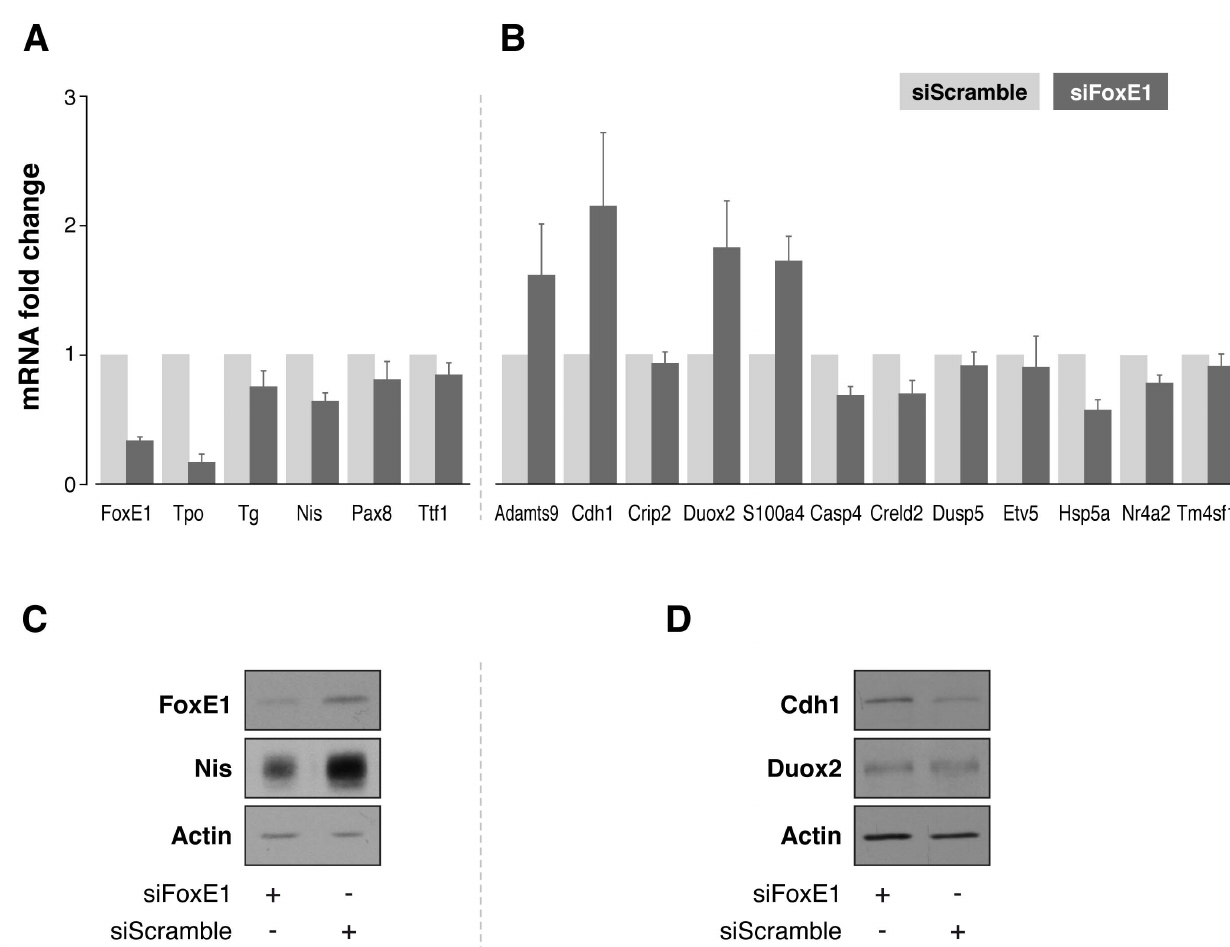
Figure 2. Experimental validation of microarray results by qRT-PCR and western blotting. Relative expression assessed by means of qRT- PCR of 6 thyroid-specific genes (panel A) and 12 additional genes differentially down- and upregulated in FoxE1-silenced PCCl3 cells (panel B). As FoxE1-dependent positive controls, we evaluated Tpo and Tg mRNA expression levels. Relative gene expression in siFoxE1 samples was calculated using the corresponding siScrambl samples as a reference (=1). Results are mean 6 SEM of four independent experiments. Total protein extracts were prepared and submitted to western blot analysis to assess the protein levels of FoxE1 and Nis (panel C), and of Cdh1 and Duox2 (panel D). Actin was used as loading control. Representative western blot assays of four independent experiments are